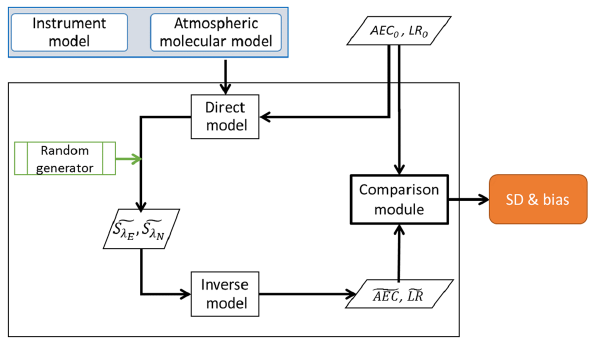
Figure 6. Block diagram of the end-to-end simulator. See text in Sect.